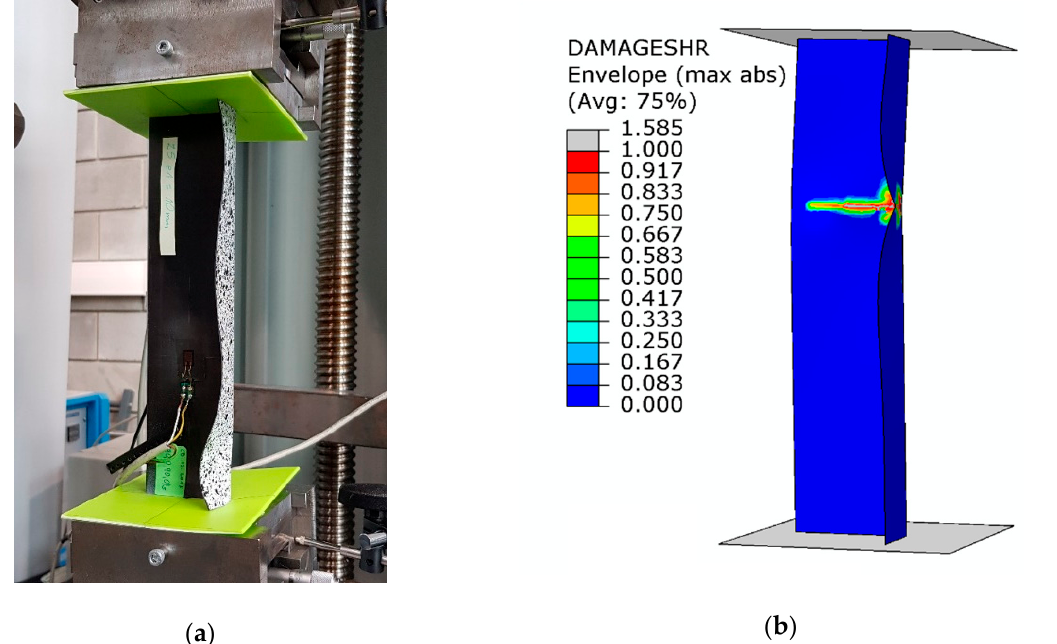
Figure 9. Buckling mode of the structure under the load eccentricity e 1 = 10 mm: ( a ) experimental; ( b ) numerical.